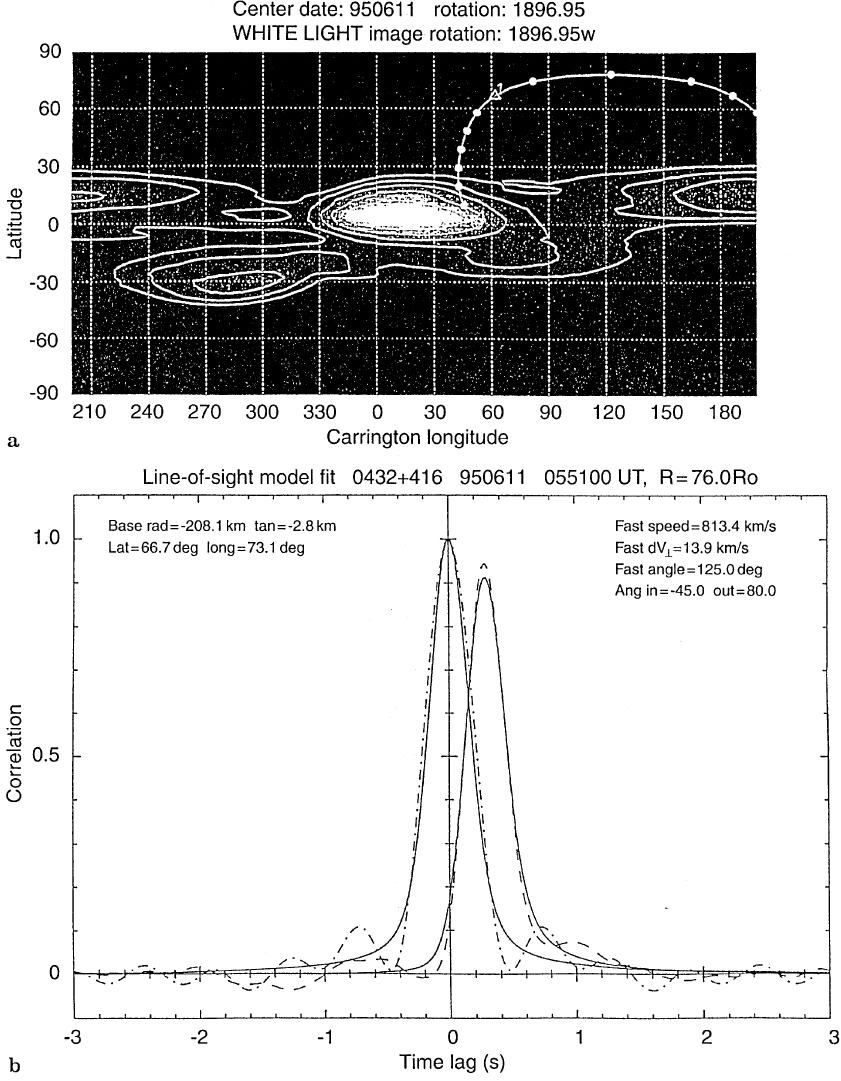
Fig. 9. a White-light map with the IPS line of sight for observations of 0432 # 416 on 11 June 1995 (a single fast stream) back- projected onto the map with an assumed constant radial velocity of 800 km s (cid:126)(cid:49) . As in Fig. 8 the closest approach of the line of sight to the Sun is marked with a triangle and the position of the Earth is shown by (cid:61) . The line of sight enters the fast stream at ! 45 ° and remains in it for the rest of its length. b IPS correlation function corre- sponding to a , analysed using the line of sight model. The dashed line represents the data and the solid line the model